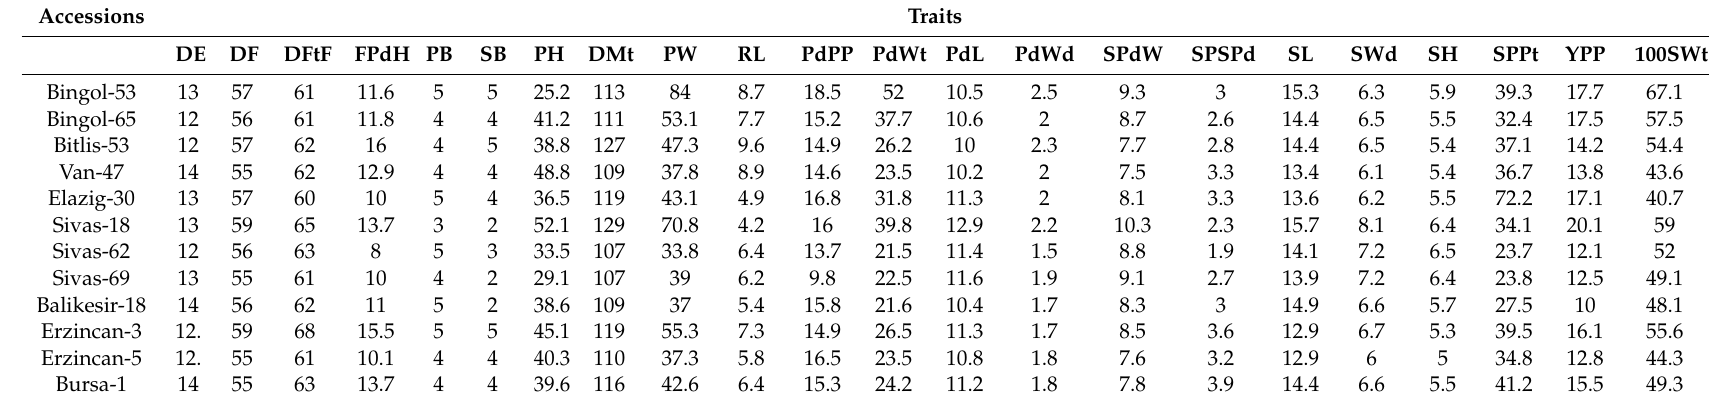
Table 6. Agro-Morphological characteristics of 12 best performing common bean accessions in five